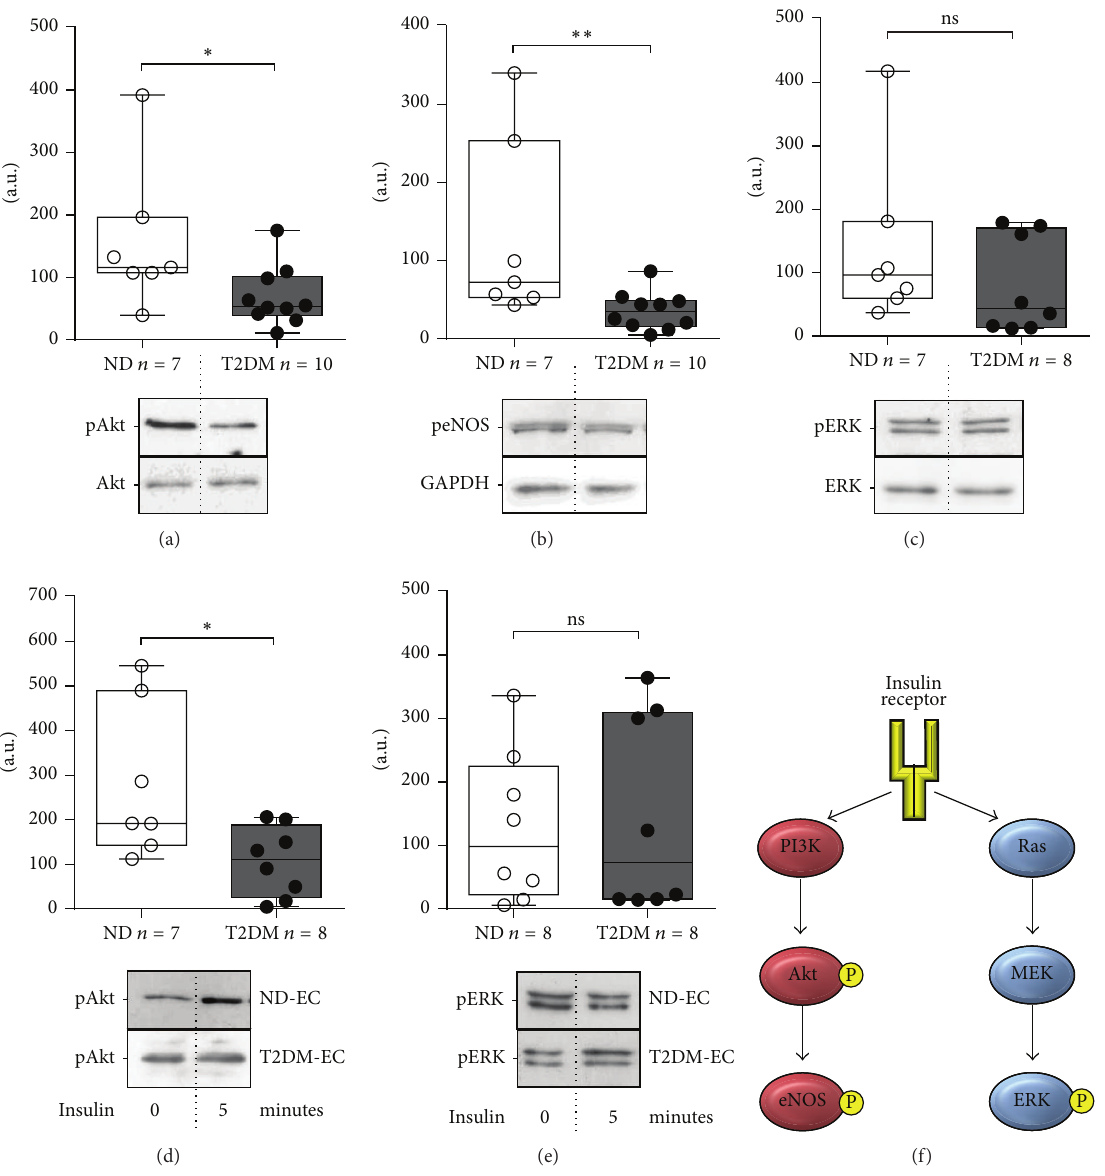
Figure 3: Intracellular signalling in SV-EC. Cells were quiesced in MM (1% FCS) for 16h and cell lysates immunoblotted for basal phosphorylation of (a) Akt, (b) eNOS, and (c) ERK. Data was normalised to a control lysate included on every blot and presented as box- and-whiskers with the median line indicated (upper panel), ∗∗ 𝑃 < 0.01 , ∗ 𝑃 < 0.05 , ns = not significant. Lower panels = representative western blots. Sensitivity to insulin was determined by treating quiesced cells with 100nM insulin for 5 min. Cell lysates were immunoblotted for phosphorylation of (d) Akt and (e) ERK; ∗ 𝑃 < 0.05 , ns = not significant. Lower panels = representative western blots showing basal phosphorylation and in response to insulin. (f) Simplified diagram of the insulin signalling pathway. P =